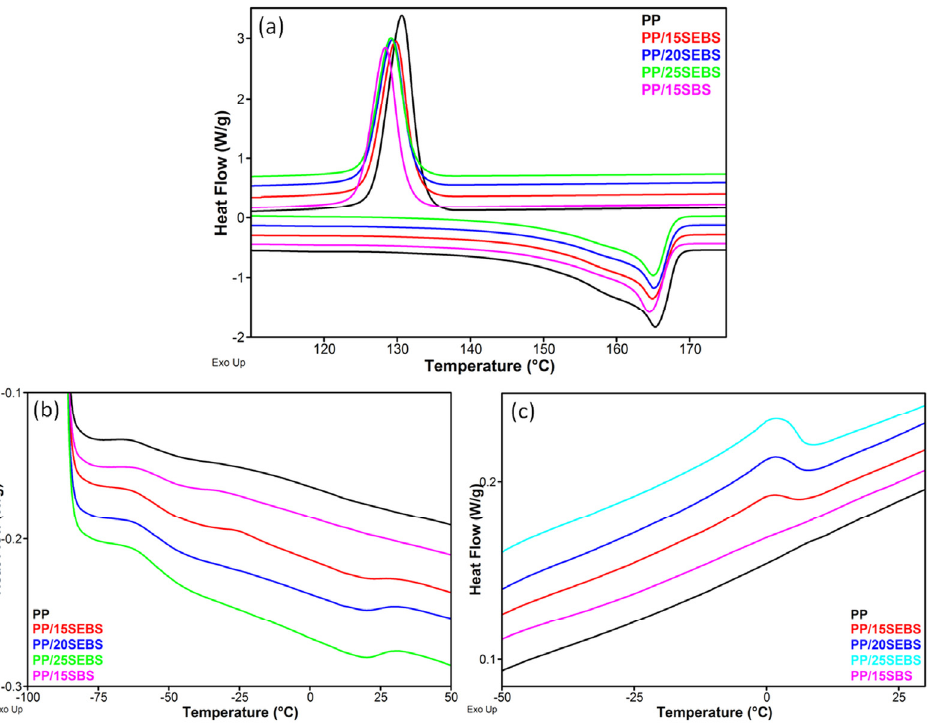
Figure 7. DSC melting and crystallization curves of the PP blends ( a ); melting curves showing the glass transition and melting of the EB blocks of SEBS ( b ); crystallization curves of the blends showing the crystallization of the EB blocks of SEBS ( c ). Table 3. DSC results, glass transition of the EB blocks ( T gEB ), melting temperature of the EB blocks ( T mEB ), PP melting temperature and corresponding enthalpy from the second heating cycle ( T mPP